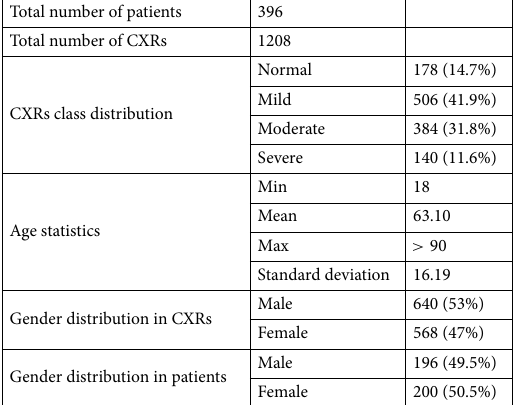
Total number of